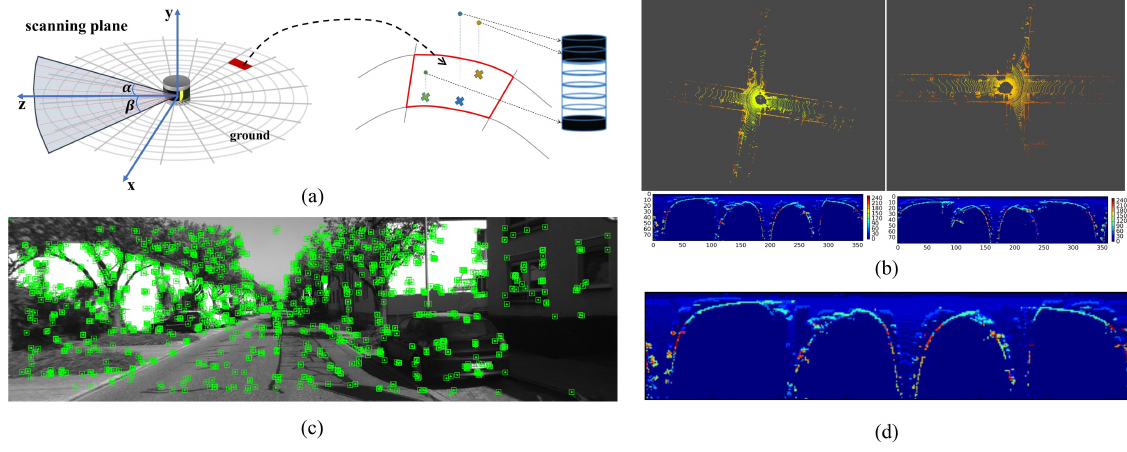
Figure 10. Features extraction for loop closure detection. ( a ) Illustration of encoding height information of surrounding objects into the LiDAR-Iris image. ( b ) Two LiDAR-Iris images (buttom row) extracted from the bird’s eye views of two LiDAR point clouds (top row) in a 3D (x,y,yaw) pose space, respectively. ( c ) ORB features extract from raw image. ( d ) shows the rotation invariance in matching two point clouds shown in ( b )